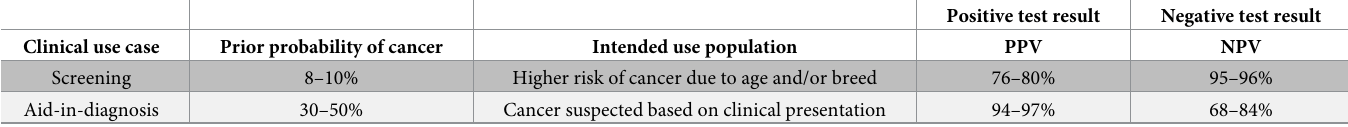
Table 8. Positive and negative predictive values based on estimated prior probabilities of cancer in two intended use